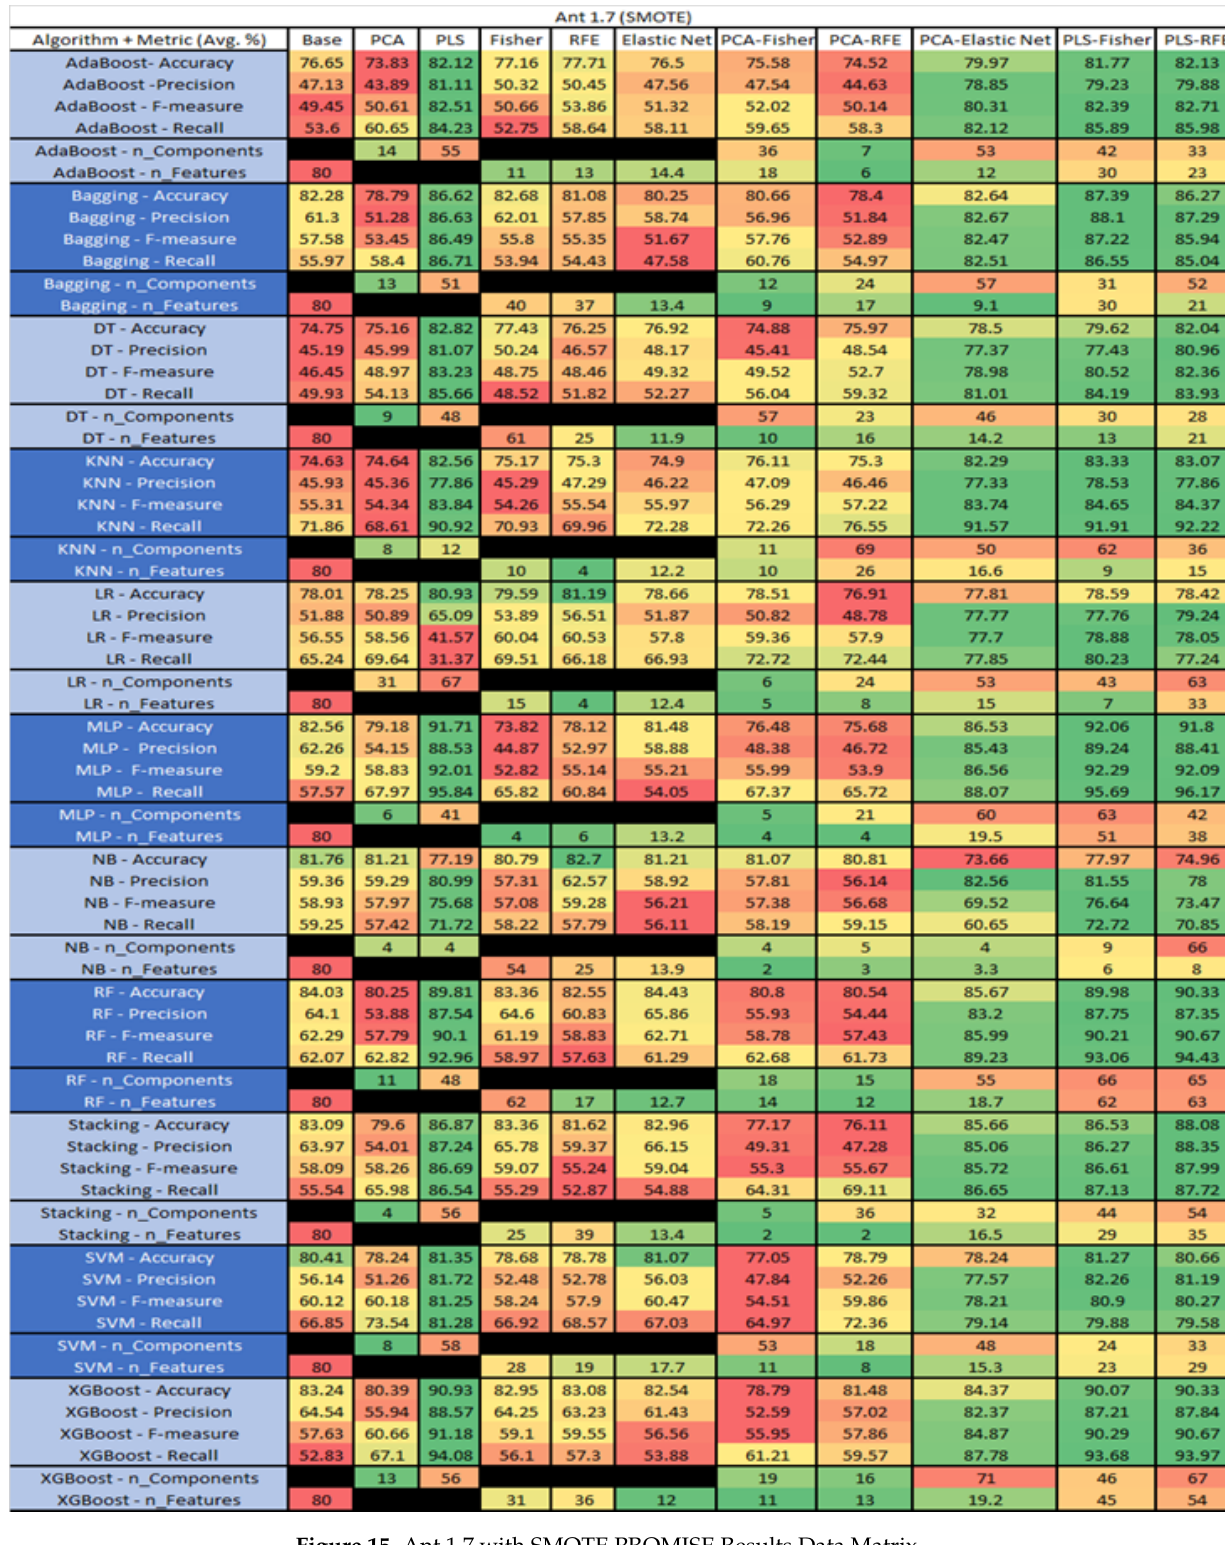
Figure 15. Ant 1.7 with SMOTE PROMISE Results Data